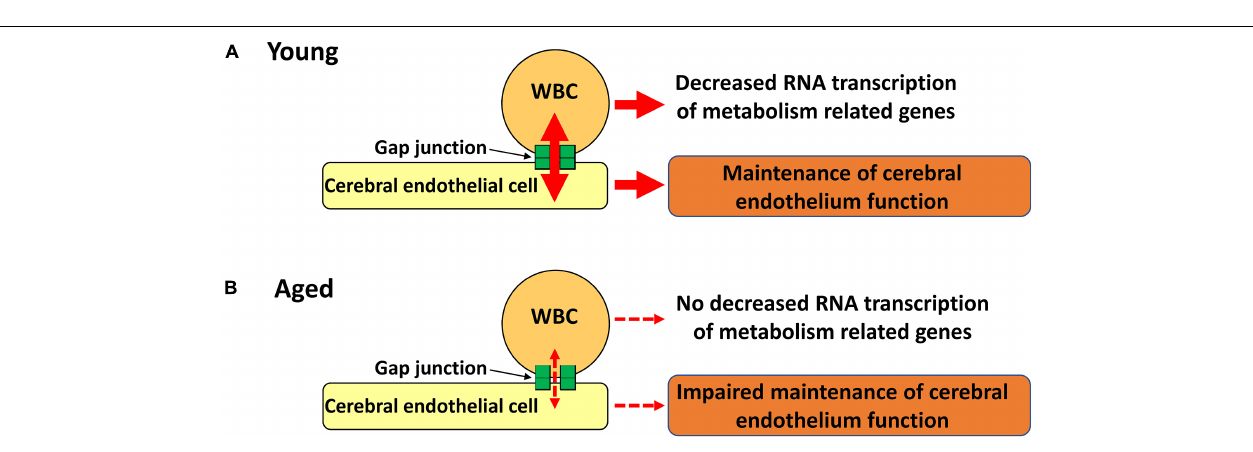
Frontiers in Aging Neuroscience |